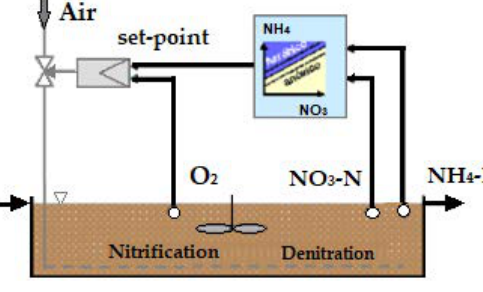
Figure 6. New aeration operation scheme.